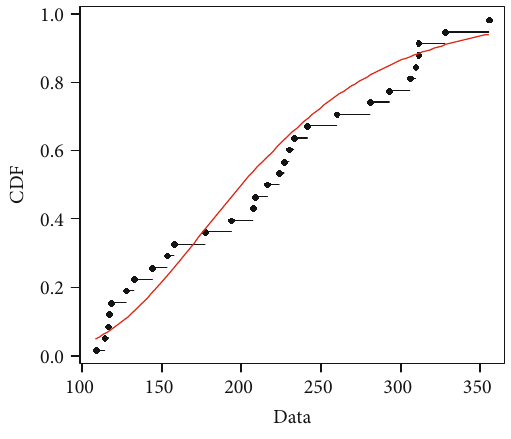
Figure 6: Theoretical and empirical CDF plot. Table 3: Imprecise data on failure times of 23 bearing balls.